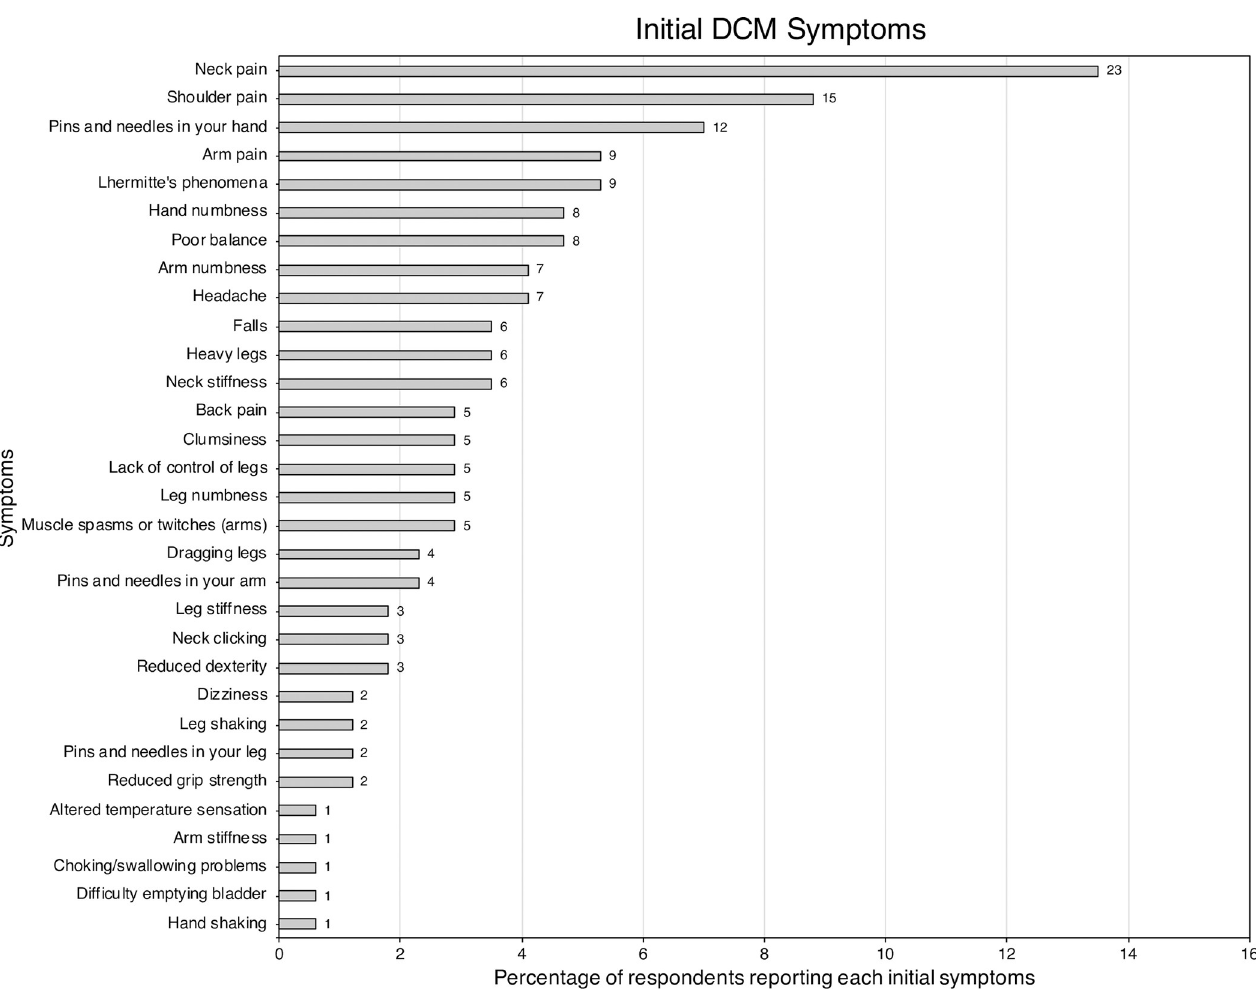
Fig 4. Bar chart of the prevalence of initial symptoms. The number of respondents reporting each initial symptom are displayed at the end of the bar.